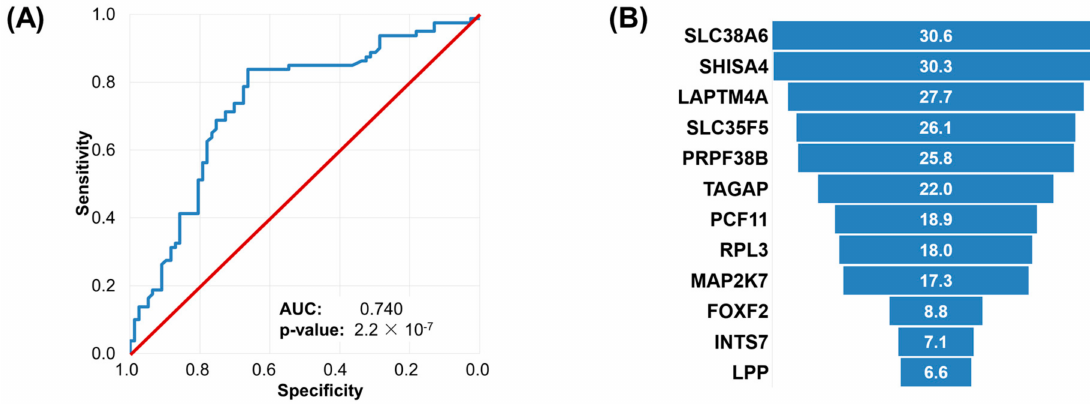
Figure 3. Performance of the random forest-based integrated predictor in the test set comprising of the human samples. The ROC curve of the random forest model tested in the human samples ( A ) and feature importance of the included genes determined by the random forest model ( B ). The red diagonal line depicts a random classifier model, whereas blue line displays our classifier